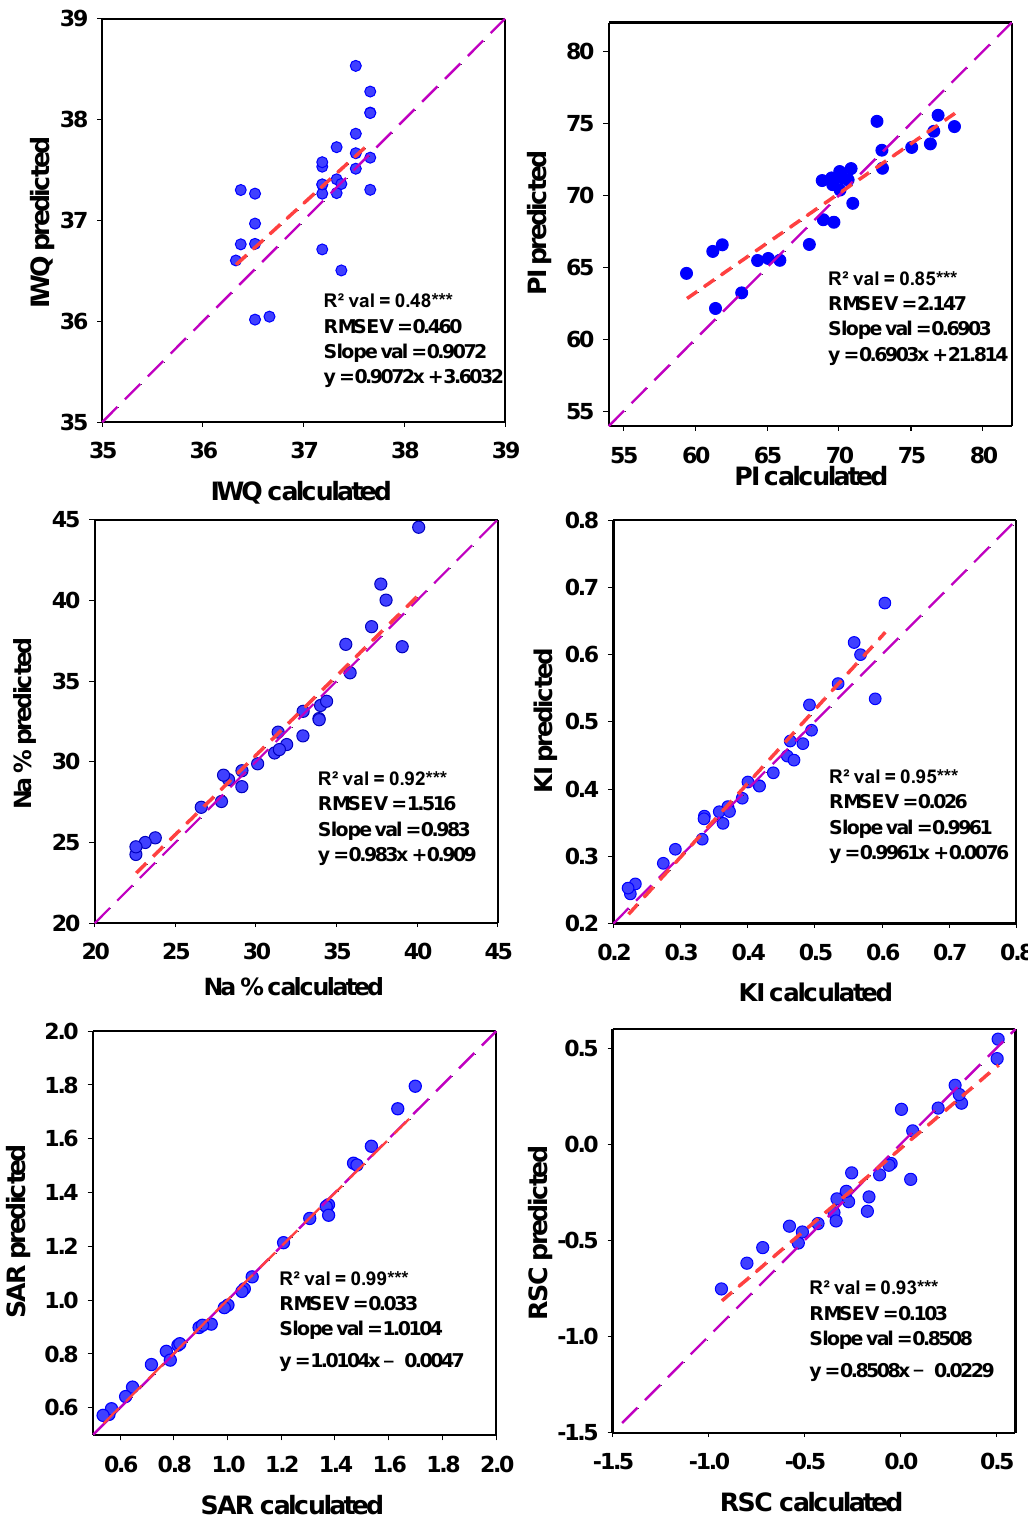
Figure 11. The validation models of relationships between observed against predicted for the six Water Quality Indices (WQIs) based on the Support Vector Machine Regression (SVMR). The SVMR models of six IWQs had R 2 values varying from 0.88 to 0.98 in the Cal. (Table 6) and varying from 0.48 to 0.99 in the Val. datasets (Figure 11), and with slopes varying from 0.77 to 1.04